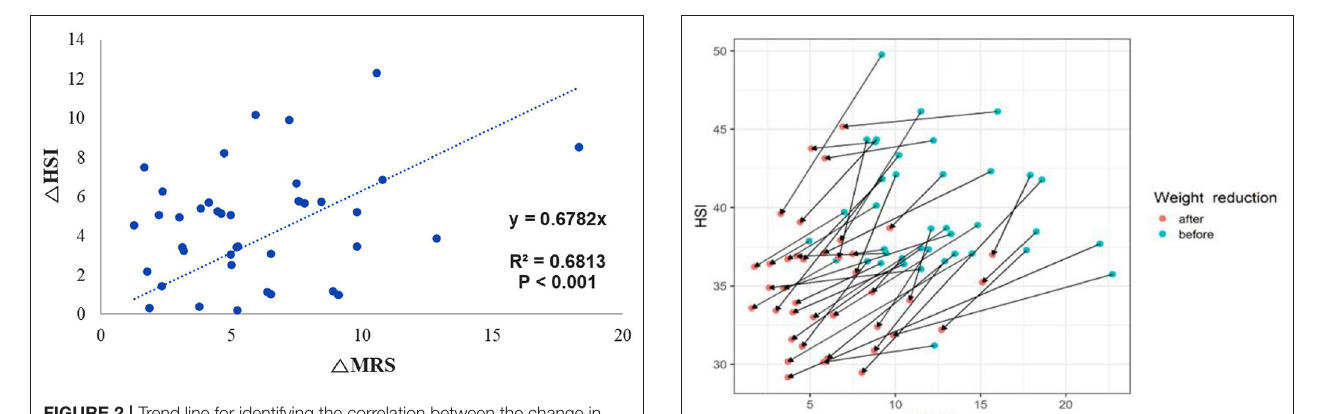
FIGURE 2 | Trend line for identifying the correlation between the change in MRS fat fraction and the change in HSI. MRS, magnetic resonance spectroscopy; HSI, hepatic stenosis index.